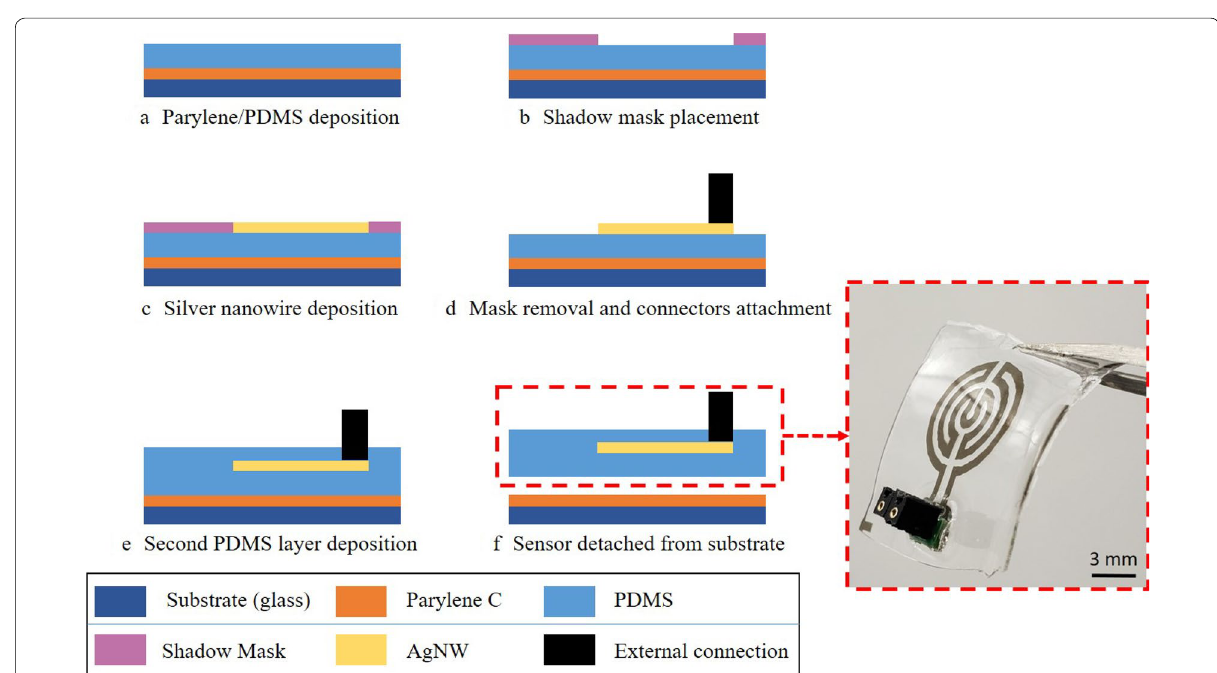
Fig. 1 Procedure to fabricate the flexible strain gauge sensor and photograph of a fabricated sensor. The red dotted box shows the fabricated sensor after it is detached from the glass substrate. The AgNW-based circular sensing part is embedded in PDMS, where a connector (black color) is also integrated for external